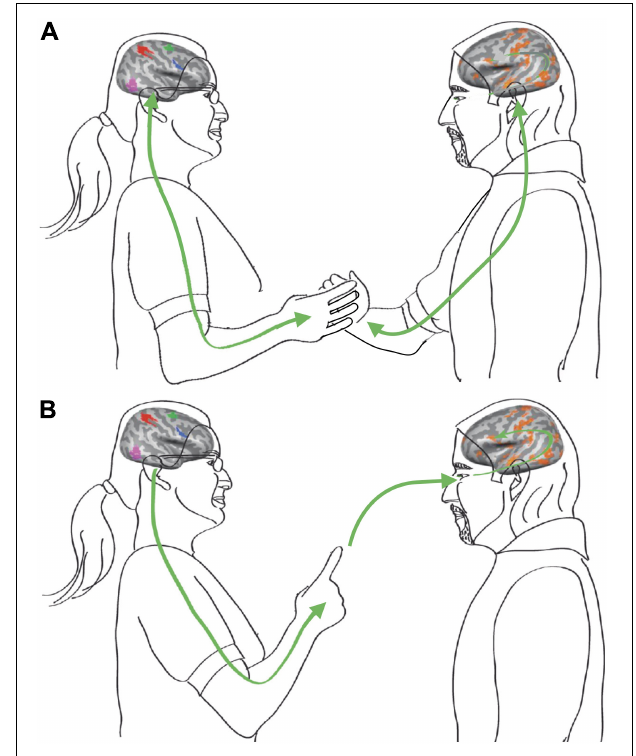
FIGURE 2 | Social interactions may involve proximal and distal types of SMCs. (A) Proximal sensorimotor coupling through direct physical contact, involving haptic sensing and kinesthesia. (B) Distal sensorimotor coupling based on distance senses including vision and audition to feed action-perception loops. Modified from Hasson et al.